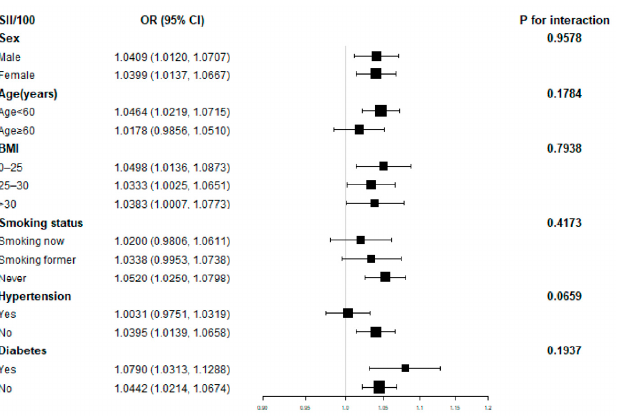
was not consistent, as shown in Figure 2. SII was shown to correlate significantly with hyperlipidemia in subgroups stratified by sex, BMI, and diabetes ( p < 0.05). Interaction tests revealed that the relationship between SII and hyperlipidemia was not statistically different across strata, showing that age, sex, BMI, smoking status, hypertension, and diabetes did not significantly impact this positive correlation ( p for interaction> 0.05).